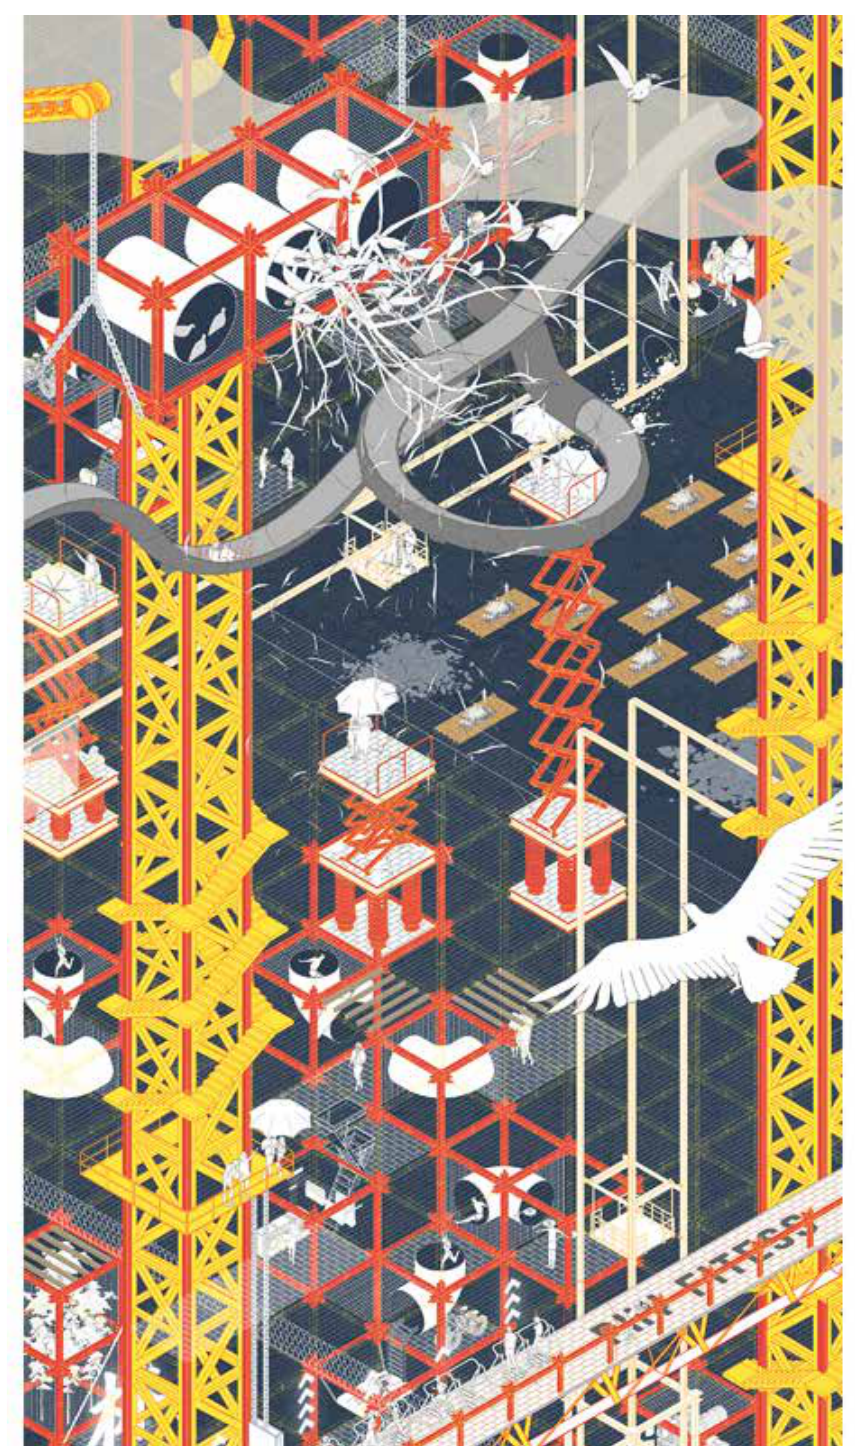
the adaptation highlights how the challenges and problems would be solved, and the change of human behaviour would be estimated. Source: Lucas